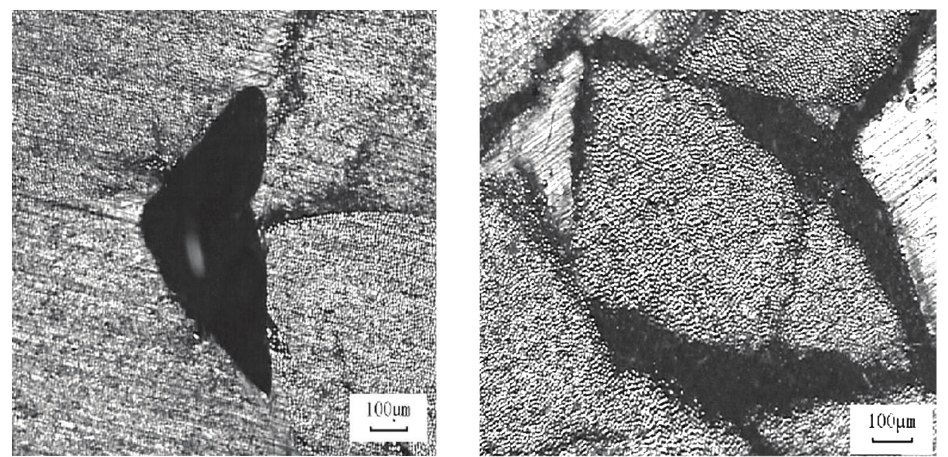
Figure 2: Cross-sectional shape of voids in resin matrix pocket of 3D braided composites [29].